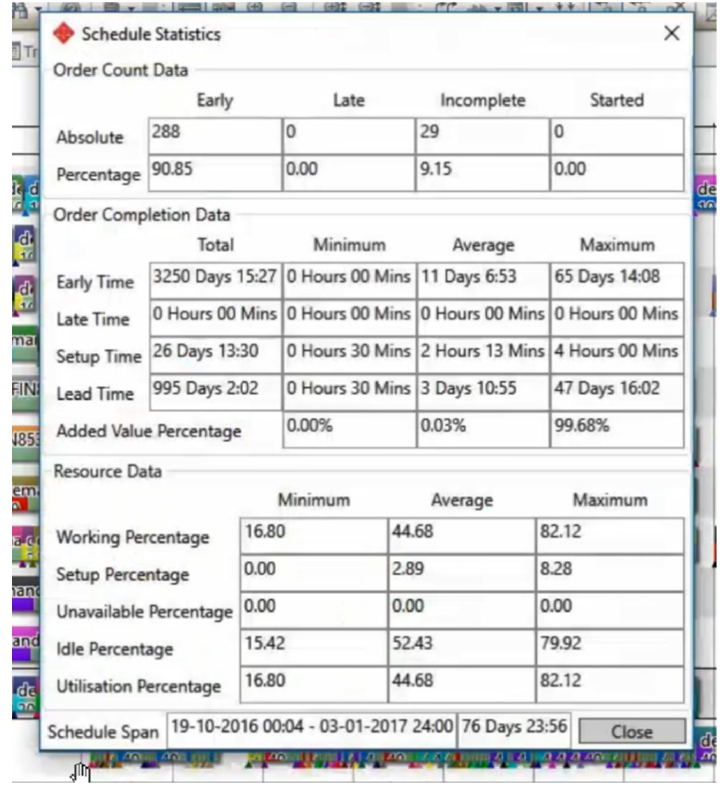
Figure 7. Forward Scheduling-Siemens Opcenter APS preview.